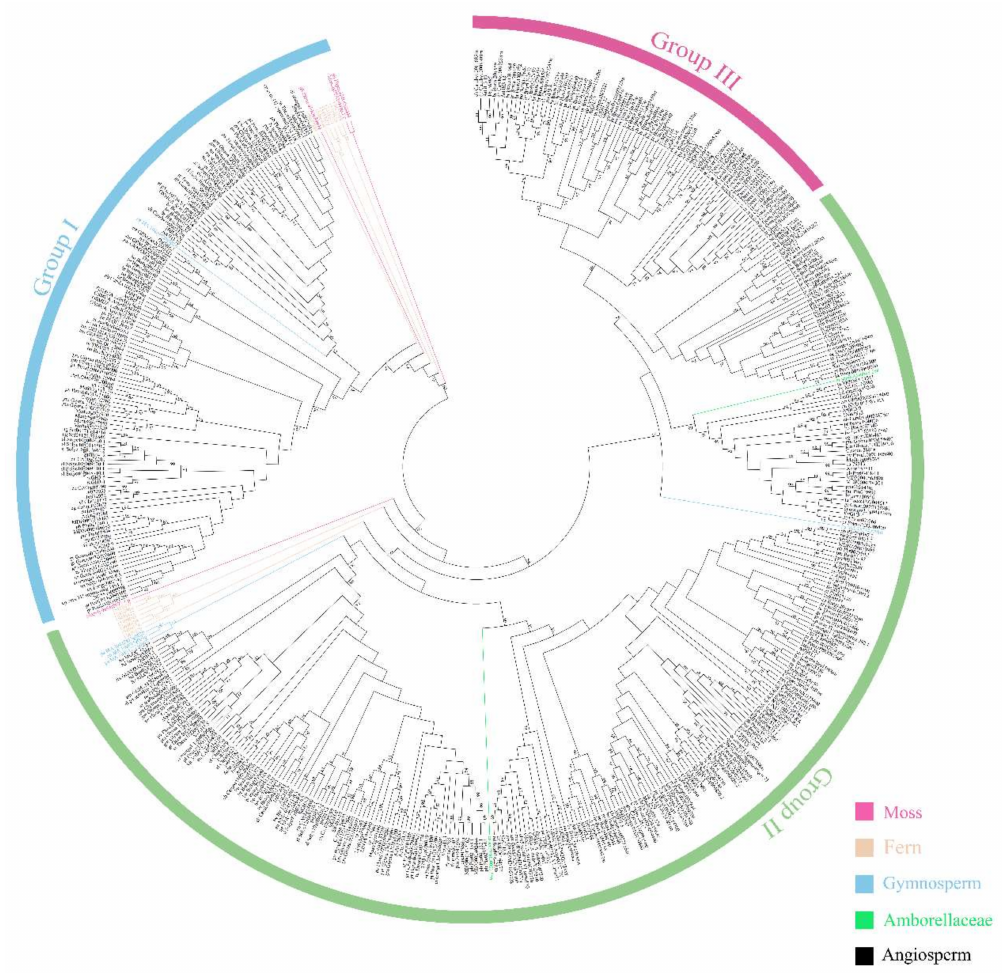
Figure 1. Unrooted Neighbor-Joining tree constructs from GH3 proteins of 48 plant species. The protein names and lines having different colors in the phylogenetic tree represent the proteins belonging to different lineages. Information for each color is displayed in the lower right corner of the figure. Subfamilies are distinguished by three curves with different colors. Blue , green , and purple indicate group I, II, and III,